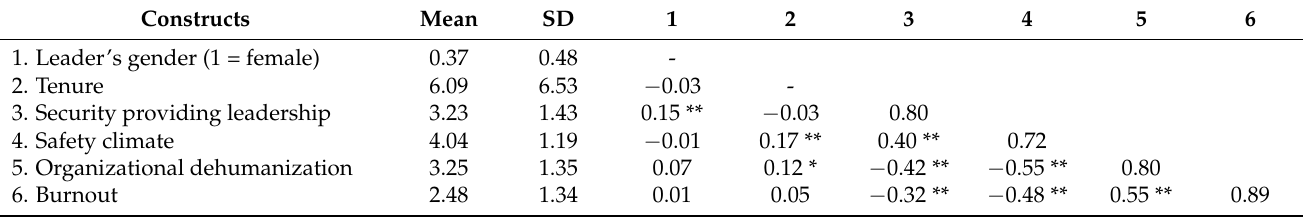
Table 1. Means, standard deviations, correlations, and discriminant